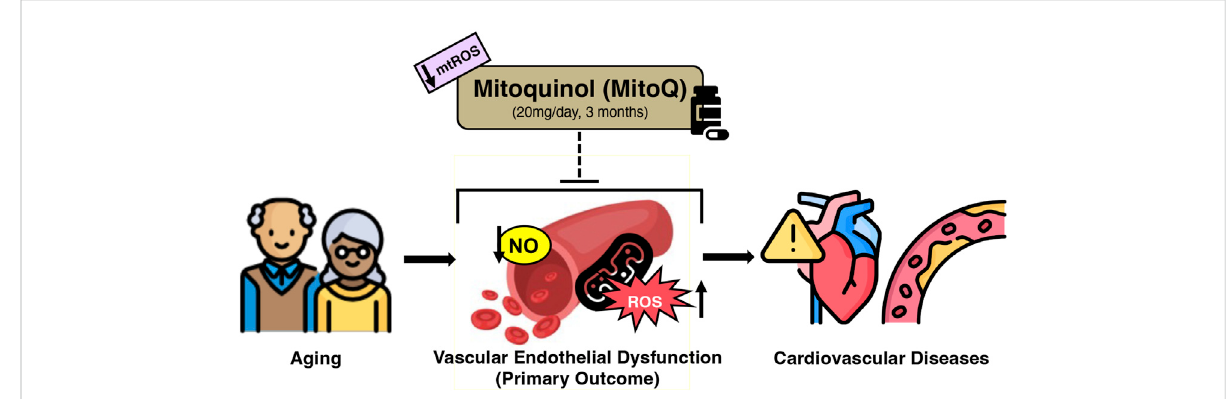
FIGURE 1 Working hypothesis of MitoQ supplementation for improving age-related declines in vascular endothelial function in healthy older adults. Created with resources from fl